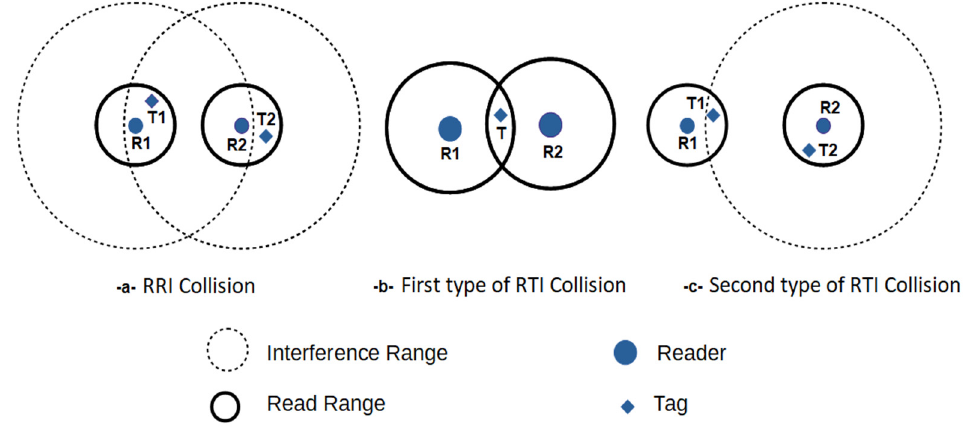
Figure 2. RFID collisions. ( a ) Reader-to-Reader Interference, ( b ) Reader-to-Tag Interference (1st type), ( c ) Reader-to-Tag Interference (2nd type)